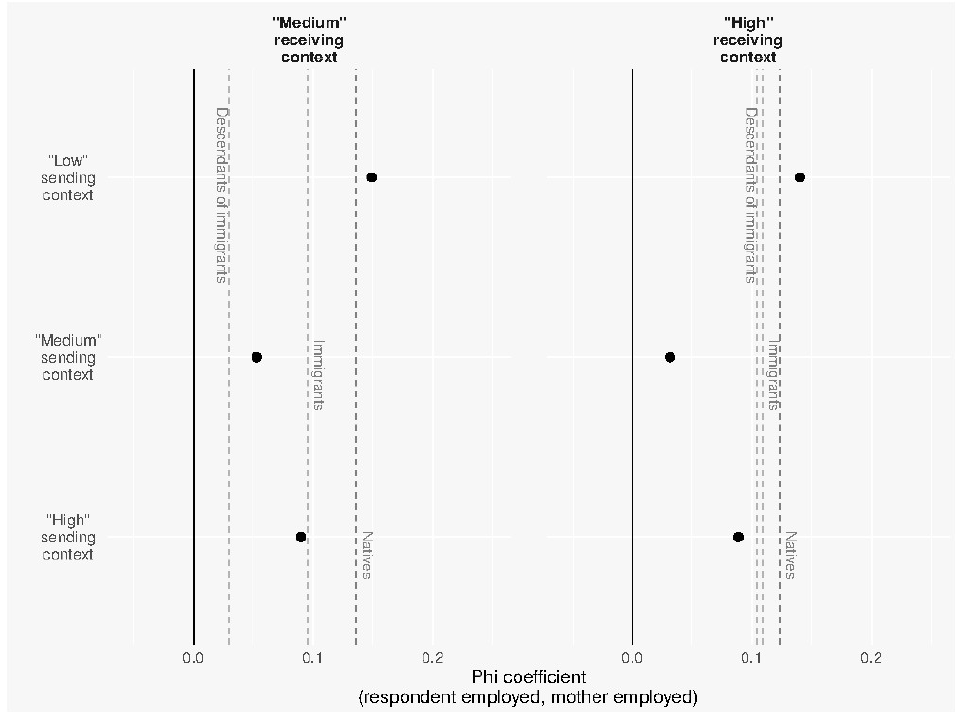
Figure 4 : Correlation between female immigrants’ employment in the ESS and their mothers’ employment for sending and receiving context group